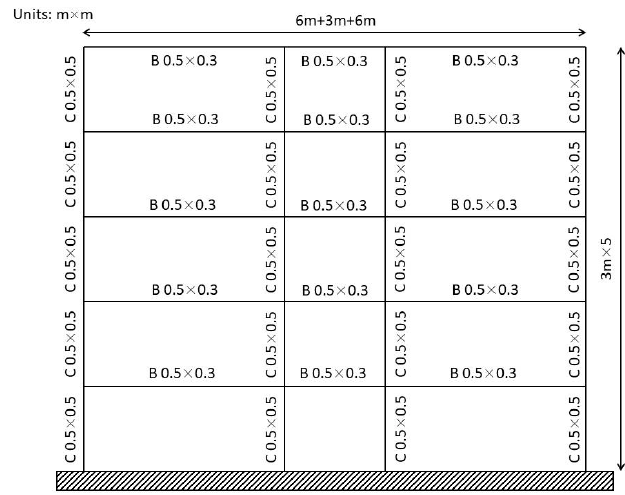
Figure 3. The example reinforcement concrete (RC) five-storey three-bay frame structure. Table 1. Cross-section and longitudinal reinforcement of beams and columns based on the Code for Seismic Design of Buildings in China (CSDBC).